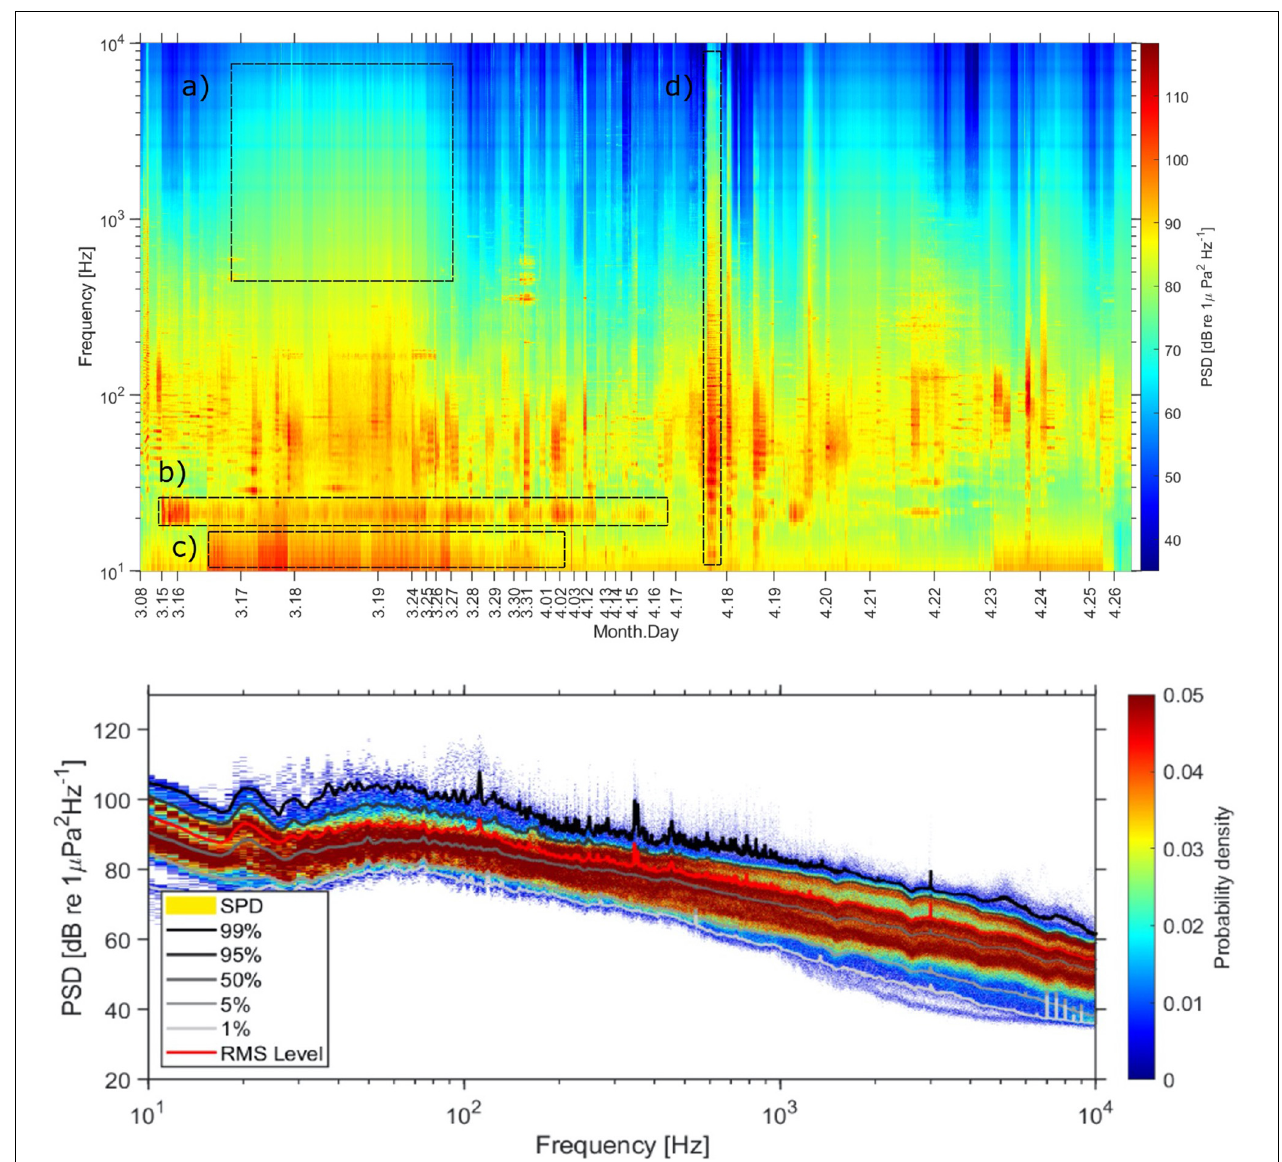
FIGURE 3 | Glider spectrogram (PSD, 1s Hann window, 60 s average) (top) and spectral probability distributions (SPD) of acoustic energy (bottom) . The different boxes indicate examples of the different sound sources; (a) wind and rain, (b) fin whale, (c) turbulent flow noise, (d) vessel in close